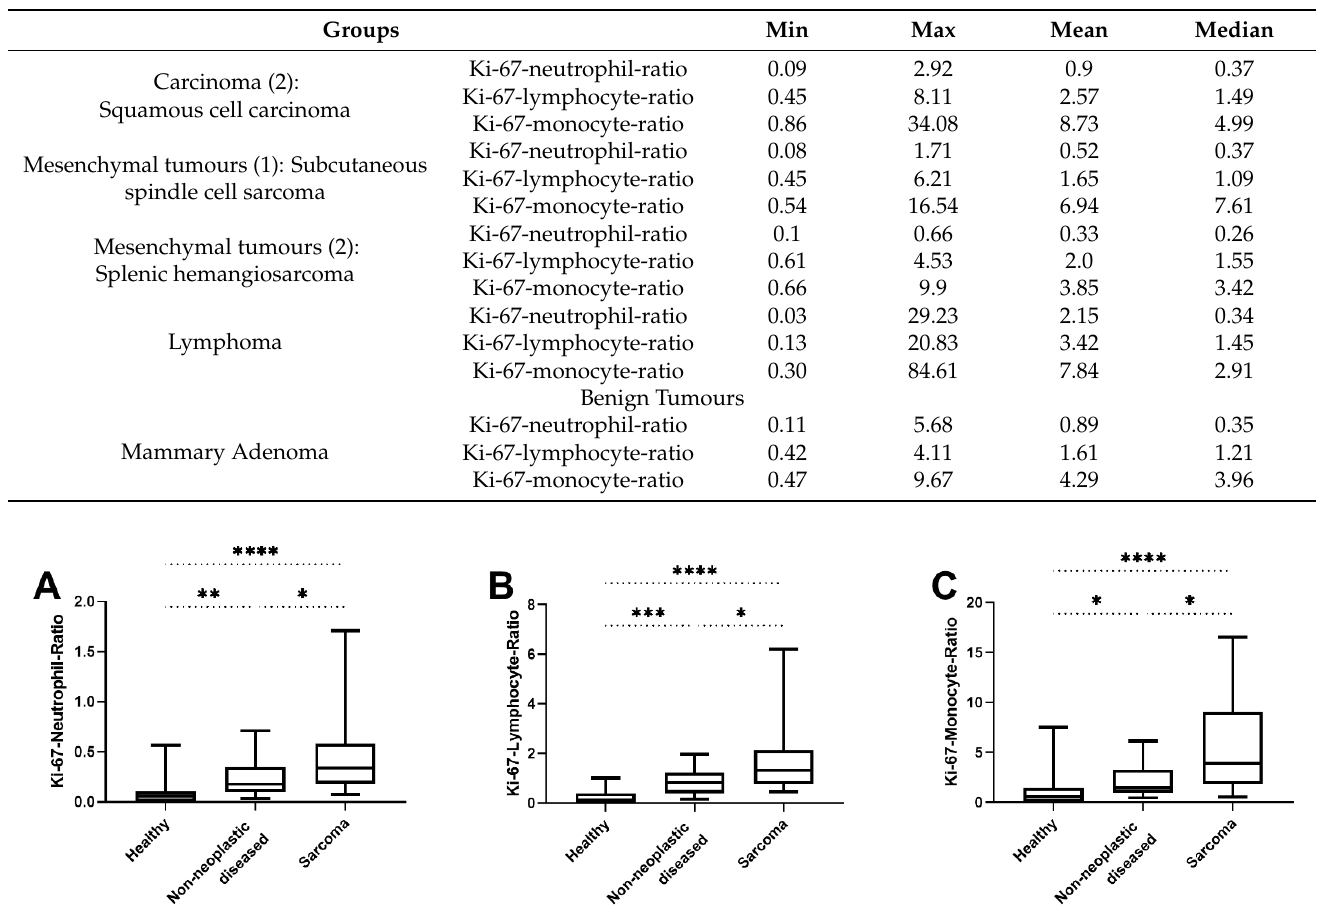
Figure 8. Comparison of ratios between Ki-67 and different inflammatory parameters of healthy dogs, dogs with non-neoplastic diseases, and the dogs with lymphoma. ( A ) The Ki-67 – neutrophil ratios of the healthy dogs were significantly lower than those of the non-neoplastic diseased and the lymphoma group ( p = 0.001 and p < 0.0001, respectively). The Ki-67 – neutrophil ratios between the non-neoplastic diseased and the malignant tumour group did not differ significantly ( p = 0.076). ( B ) The Ki-67 – lymphocyte ratios of the healthy dogs were also significantly lower than those of the non- neoplastic diseased and the lymphoma group ( p = 0.0002 and p < 0.0001, respectively). Additionally, the Ki-67 – lymphocyte ratios between the non-neoplastic diseased and the lymphoma group did not differ significantly ( p = 0.104). ( C ) The Ki-67-monocyte ratios of the non-neoplastic diseased dogs were significantly higher than those of the healthy group and the healthy group had significantly lower values than the lymphoma group ( p = 0.005 and p < 0.0001, respectively). The Ki-67 – monocyte ratios between the non-neoplastic diseased and the lymphoma group did not differ significantly ( p = 0.16). (ns) not significant; (**) p < 0.01; (***) p < 0.001; (****) p < 0.0001.